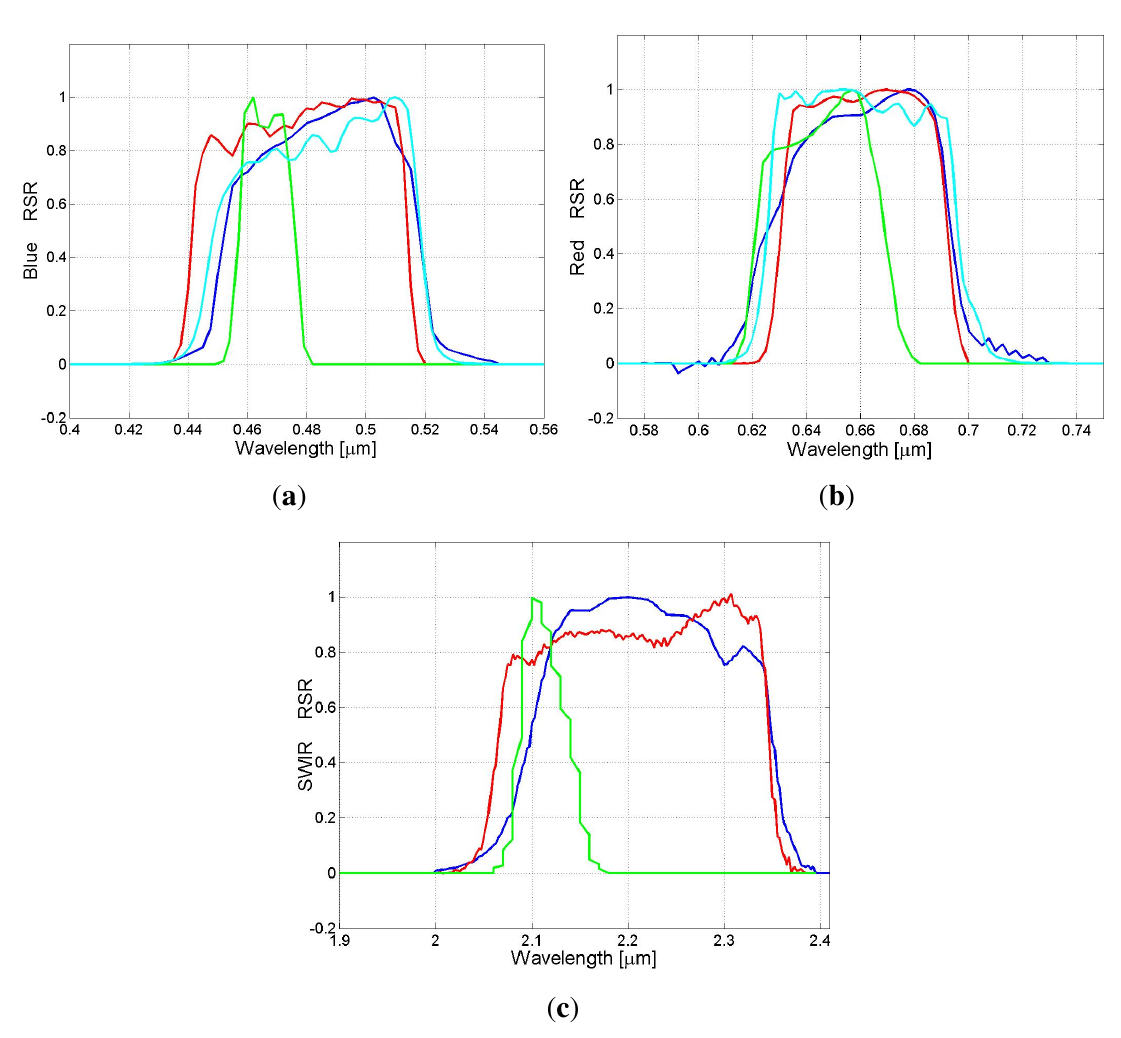
Figure 4. Comparison of the relative spectral responses of LandSat-5 (blue), LandSat-7 (red), FormoSat-2 (cyan) and MODIS (green), for the blue ( a ), red ( b ) and SWIR (2.2 µ m) ( c )